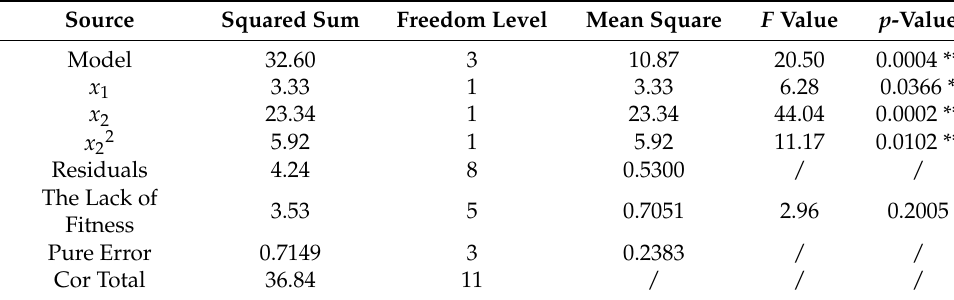
Table 5. QRSRD variance